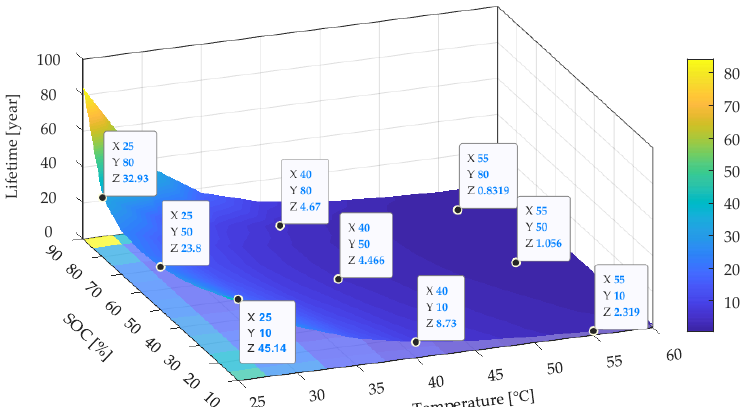
Figure 12. Lifetime prediction results using the established capacity fade model (when 20% capacity fade EOL criterion has been reached).